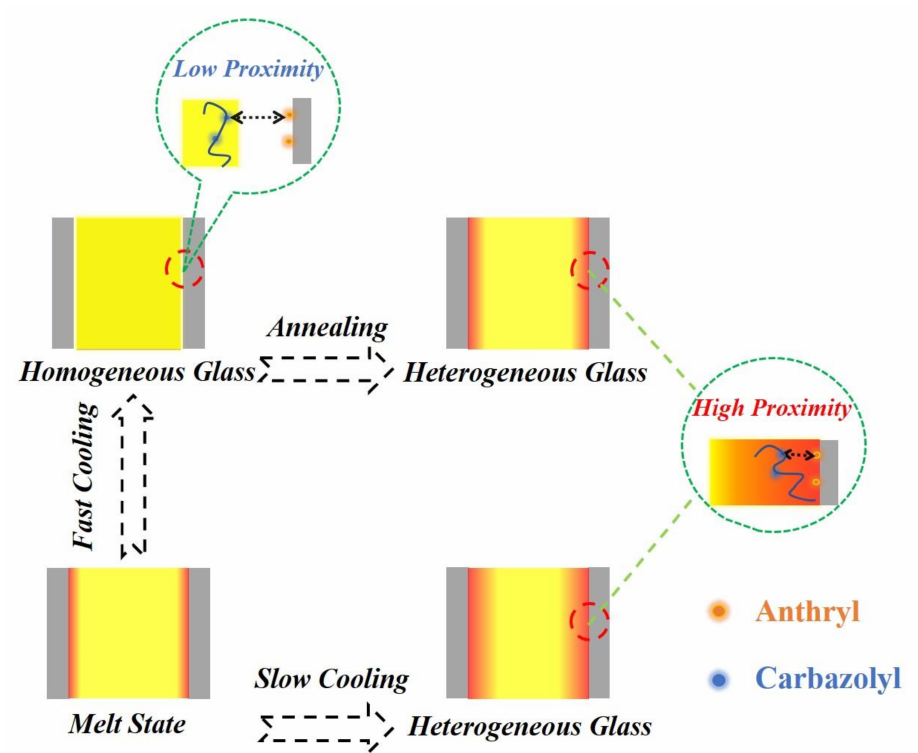
Figure 7. The evolution of nanostructure of polymer nanorods confined in nanopores during the cooling process from melt to glass. The solid luminous dots represent the fluorophores, with red dots as donors and blue dots as acceptors. The red area represents the absorbed layer, and the yellow area represents the bulk-like